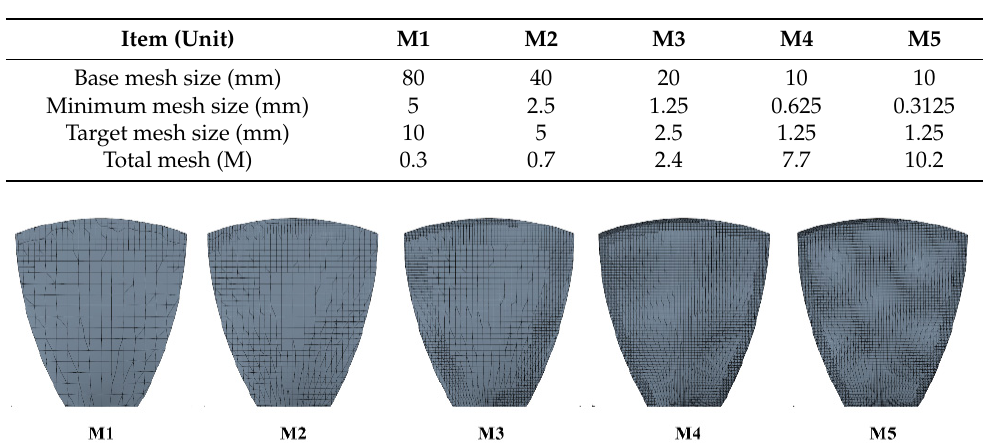
Figure 4. Five groups of propeller blade surface meshes.